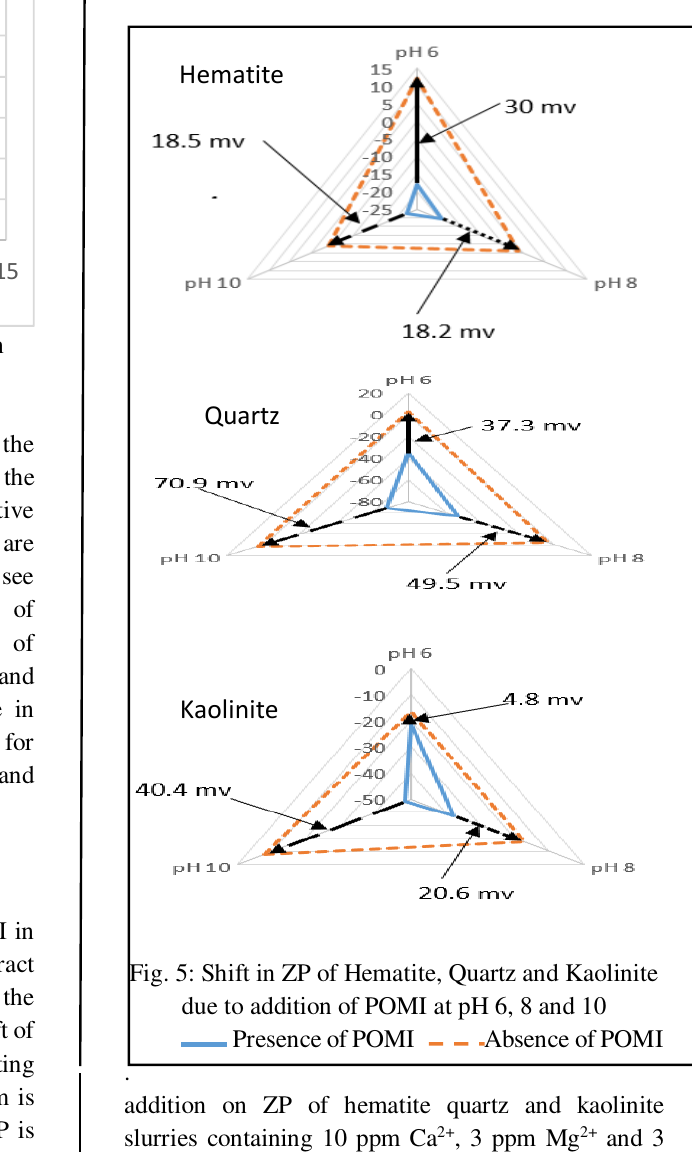
Fig. 5: Shift in ZP of Hematite, Quartz and Kaolinite due to addition of POMI at pH 6, 8 and 10 Presence of POMI Absence of POMI . addition on ZP of hematite quartz and kaolinite slurries containing 10 ppm Ca 2+ , 3 ppm Mg 2+ and